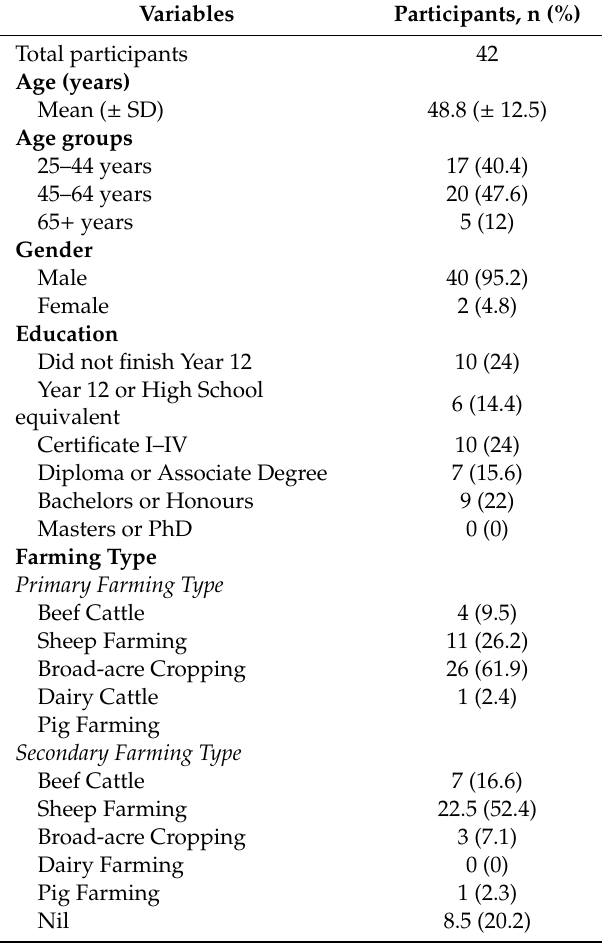
Table 2. Participant demographics and health behaviours (n =